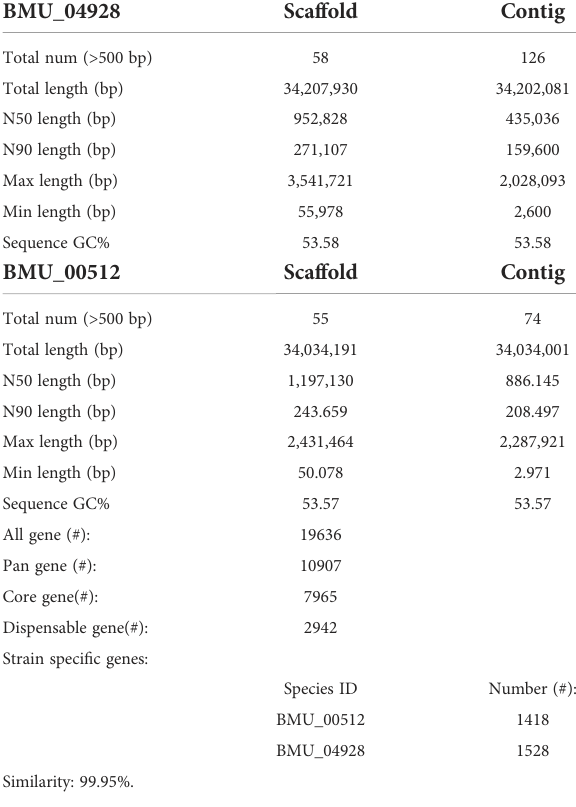
TABLE 1 Genomic assembly and annotation statistics for BMU 00512 and BMU 04928.